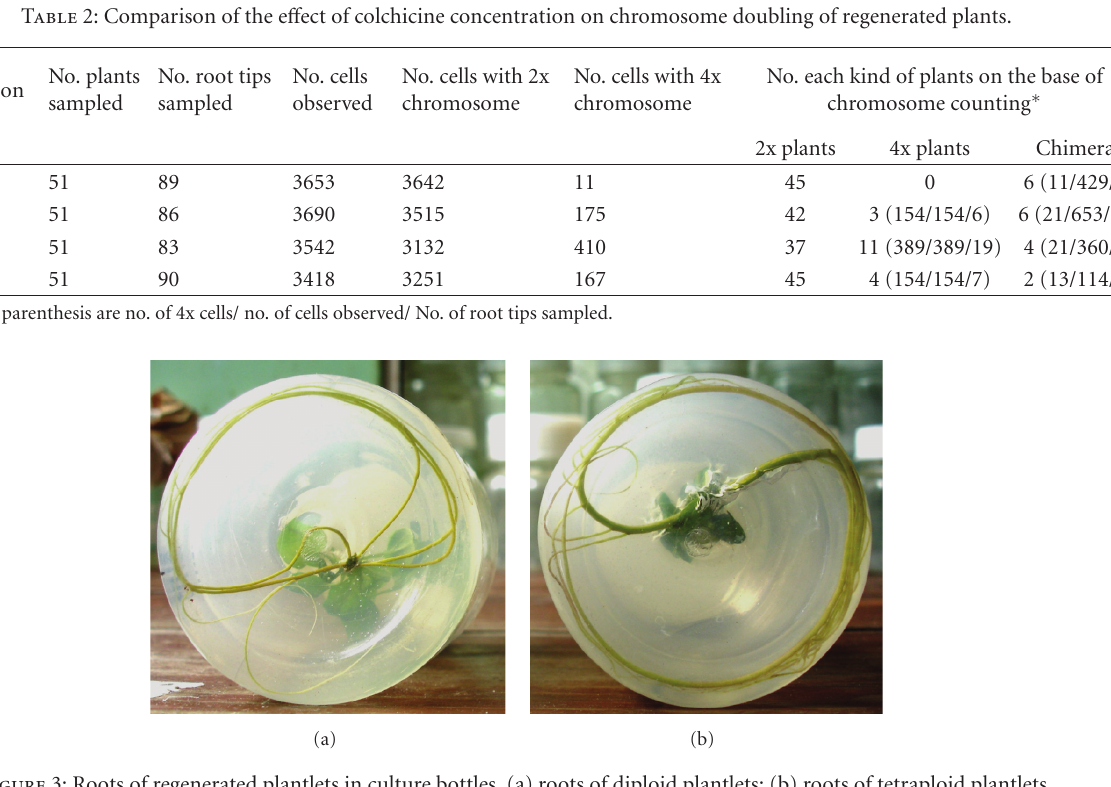
Figure 3: Roots of regenerated plantlets in culture bottles. (a) roots of diploid plantlets; (b) roots of tetraploid plantlets.